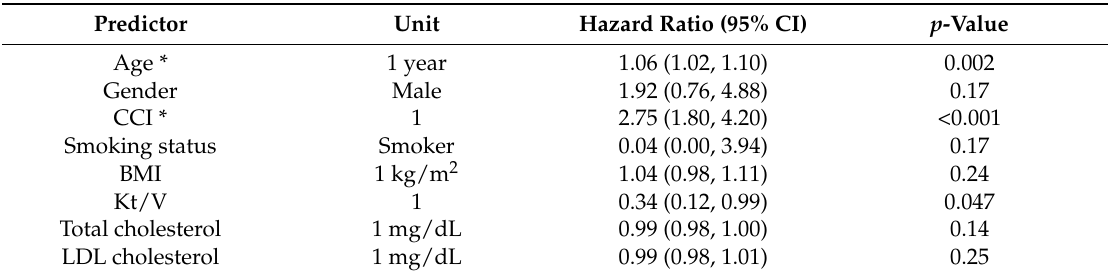
Table A1. Univariate Cox proportional hazards regression of matching variables and variables differing between